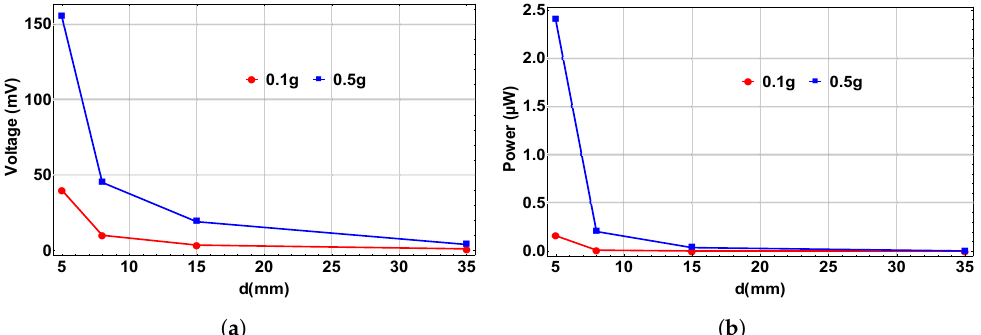
Figure 12. ( a ) The variation in the output voltage with separation distance at different excitation levels. ( b ) The variation in the output power with separation distance at different excitation